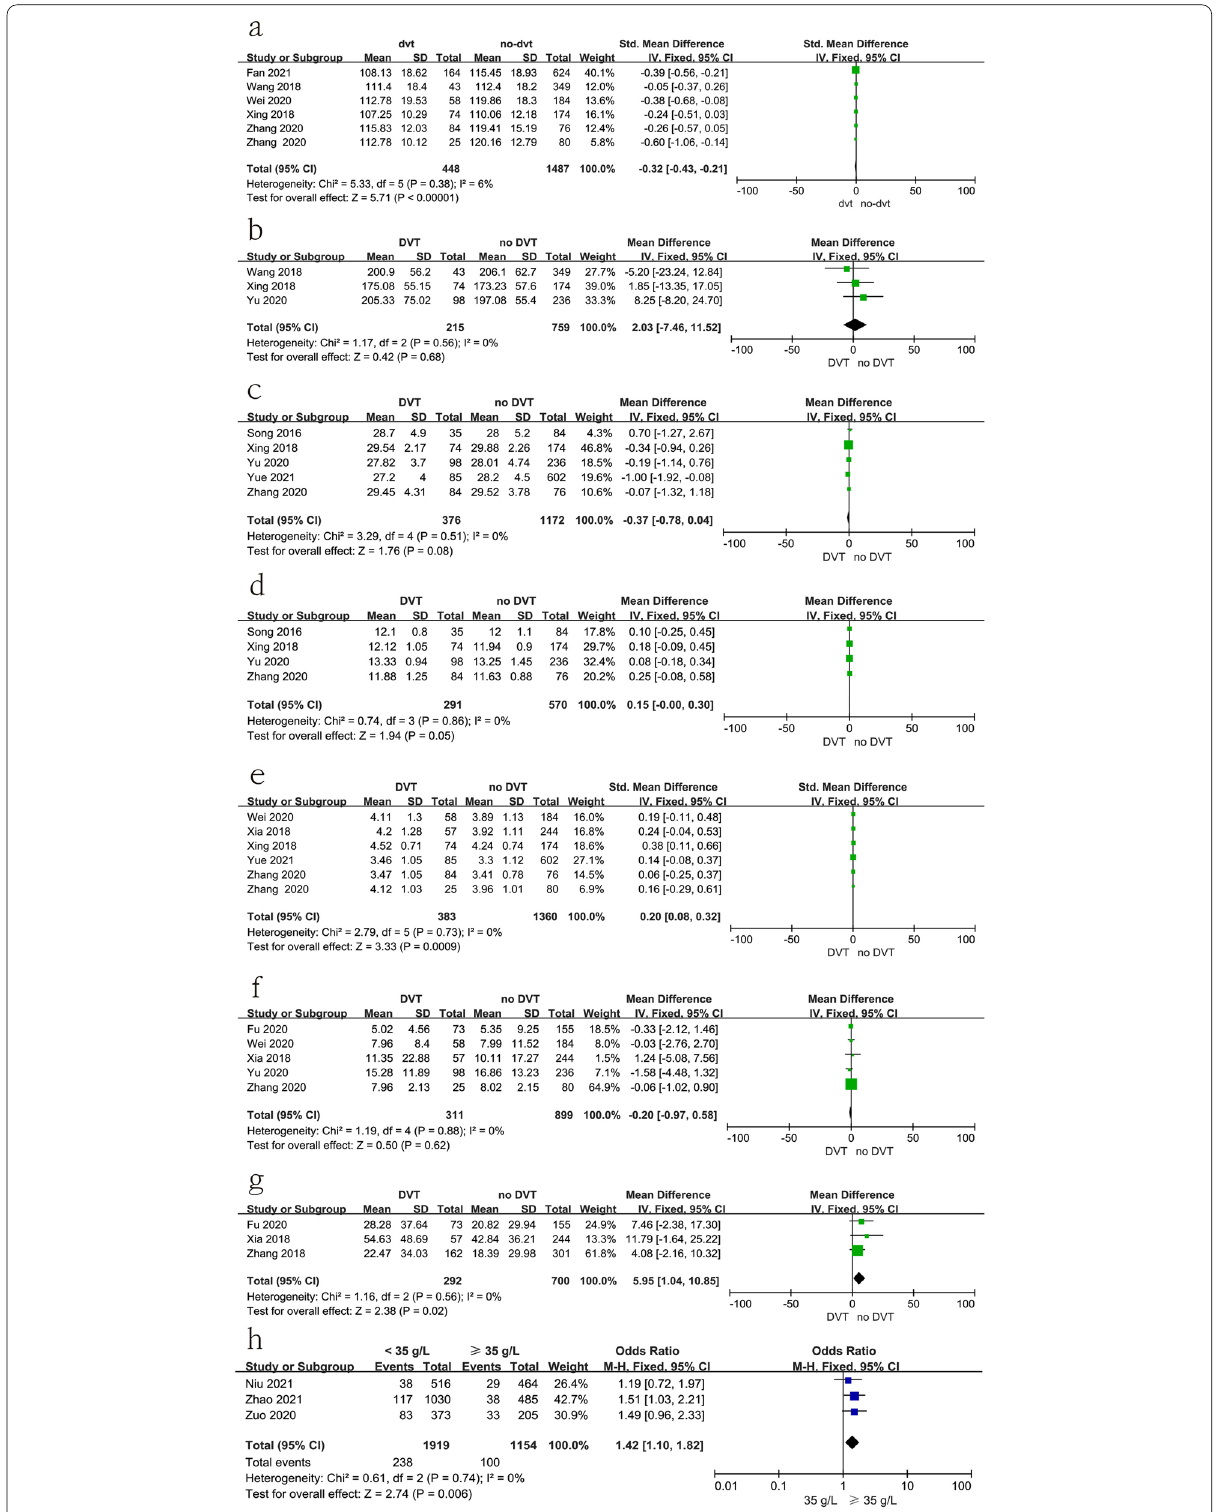
Fig. 16 Forest plot showing the relationship between laboratory test and preoperative DVT in 2 groups. CI confidence interval, df degrees of freedom, M-H Mantel–Haenszel. a Hemoglobin; b platelet; c activated partial thromboplastin time (APTT); d activated prothrombin time (PT); e fibrinogen; f D-dimer; g C-reactive protein (CRP); h albumin (< 35 g/l vs 35 ≥